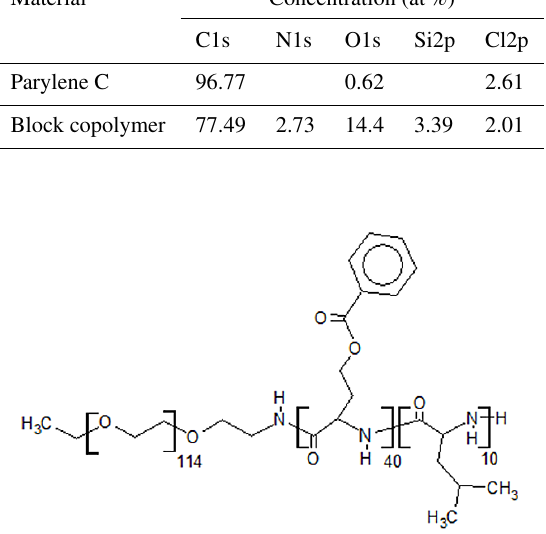
Figure 7. Structural formula of the block copolymer PEG 114 -b- p(L-Glu) 40 -b-p(L-Leu) 10 .